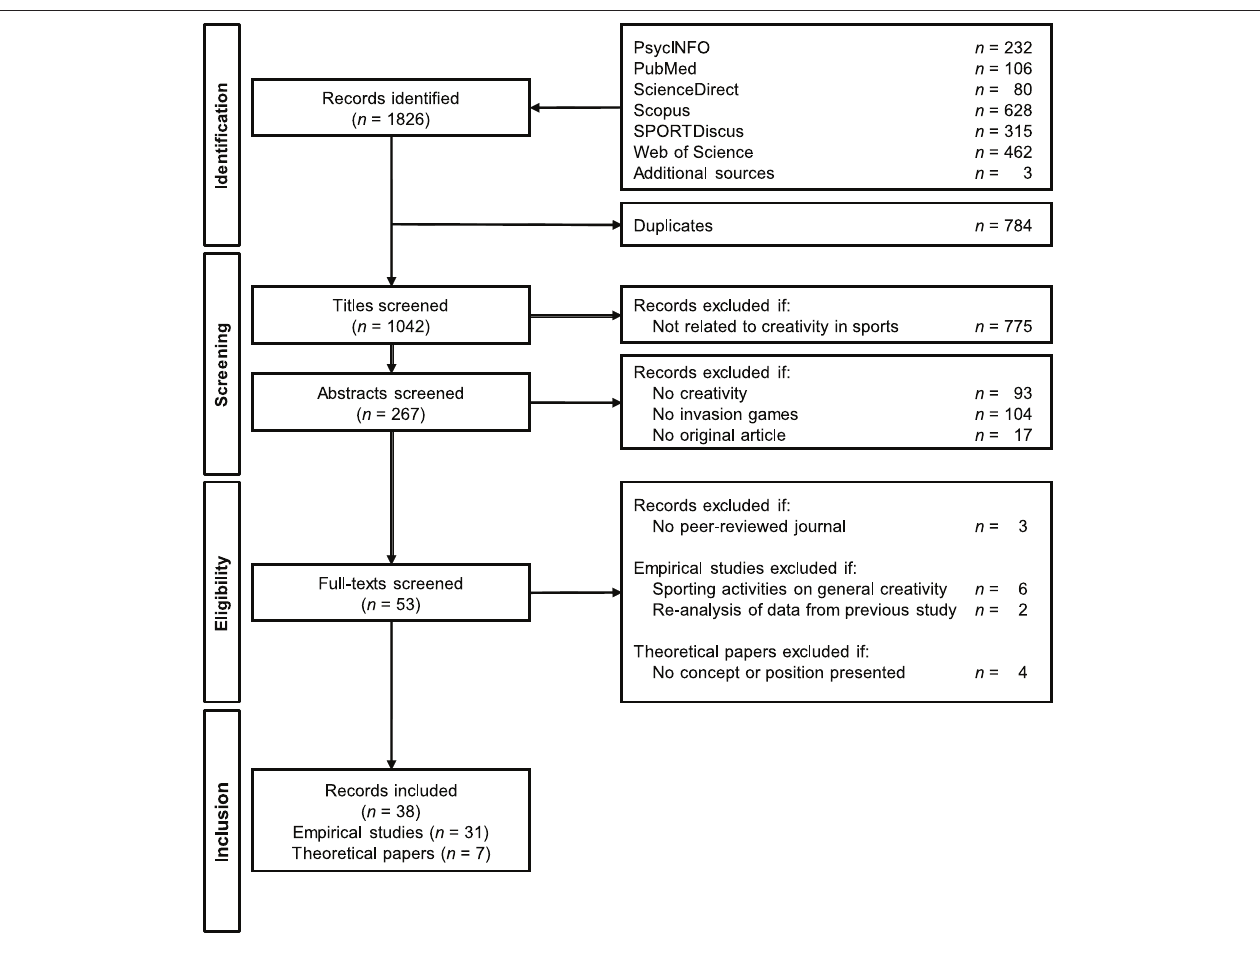
FIGURE 1 | PRISMA flow diagram for the literature